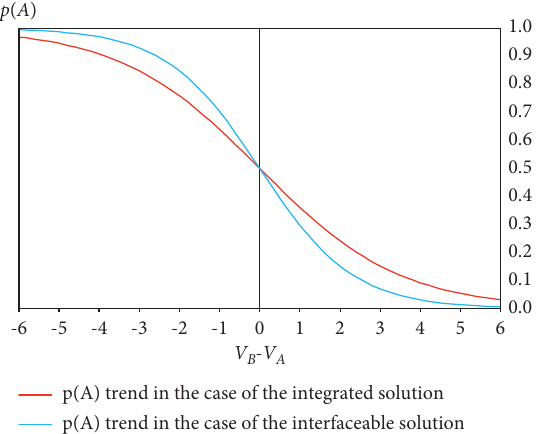
Figure 16: Comparison between the two approaches analysed (i.e., integrated vs interfaceable solution) in terms of route choice